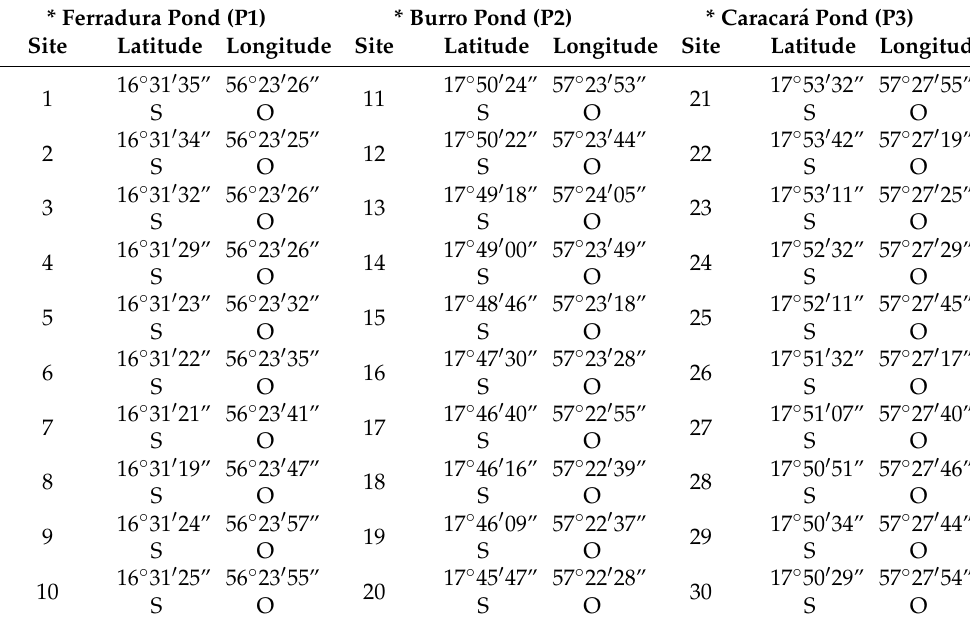
Table 1. Geographic coordinates of the sampling sites corresponding to the three ponds. * Ferradura Pond